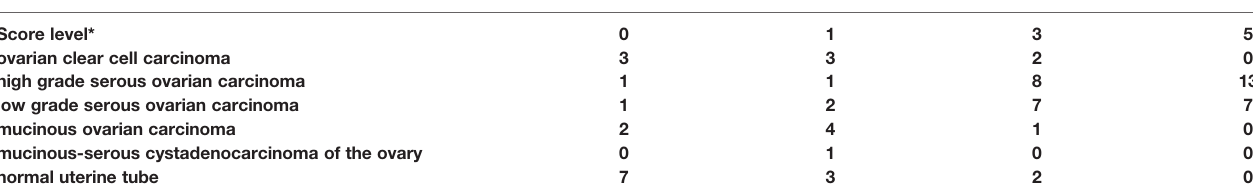
TABLE 2 | Expression of MSLN in different ovarian tissue.